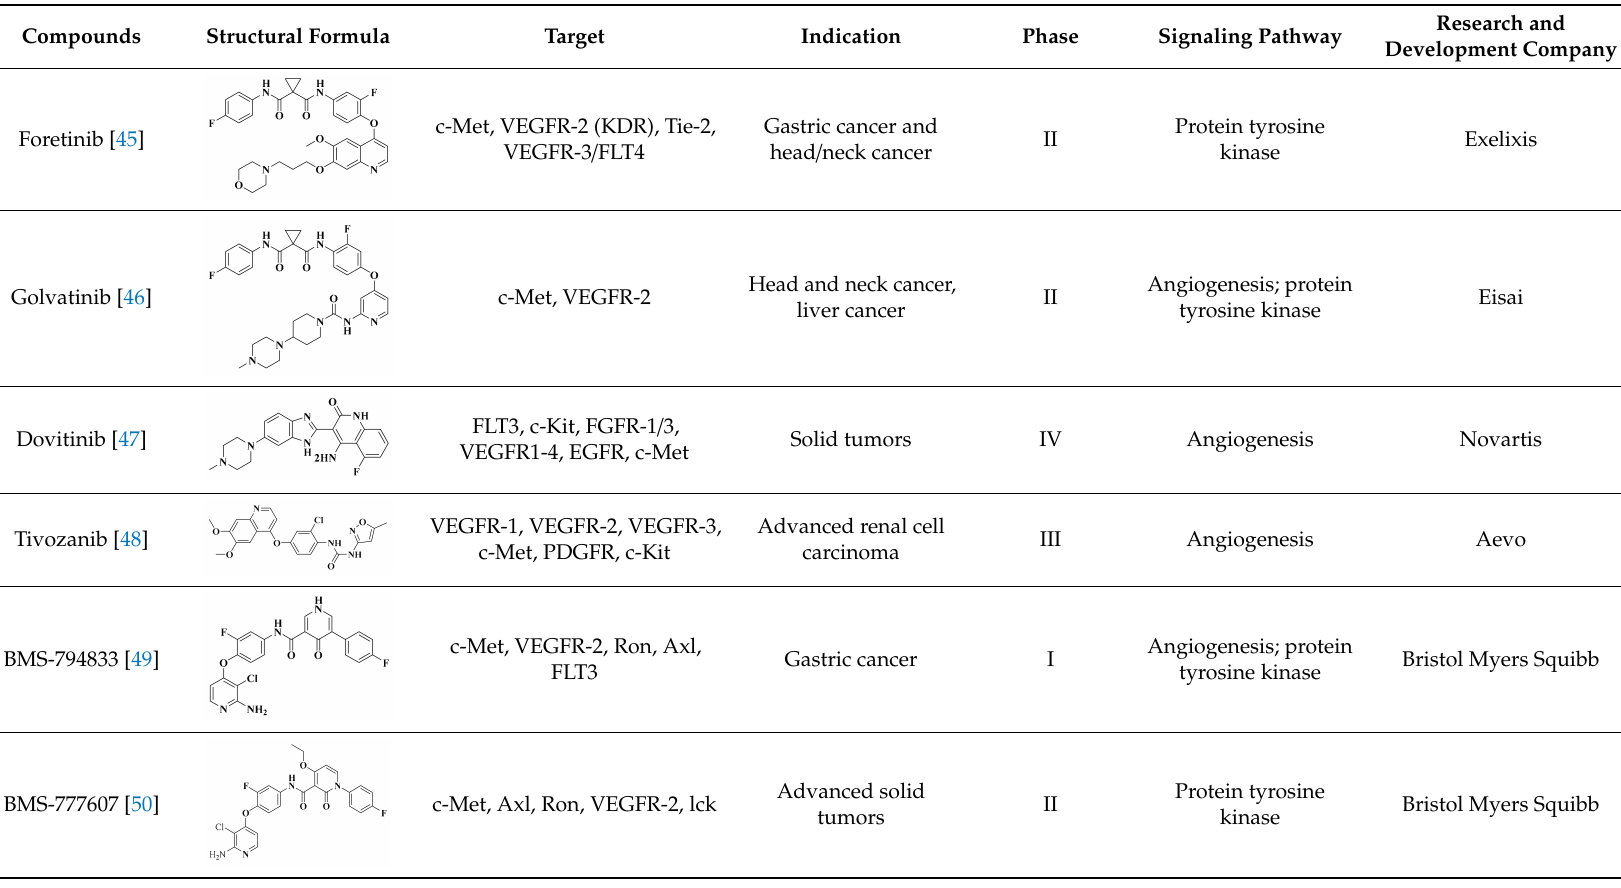
Table 1. Multi-target vascular endothelial growth factor receptor / mesenchymal epithelial transfer factor tyrosine kinase (VEGFR / c-Met) inhibitors in clinical